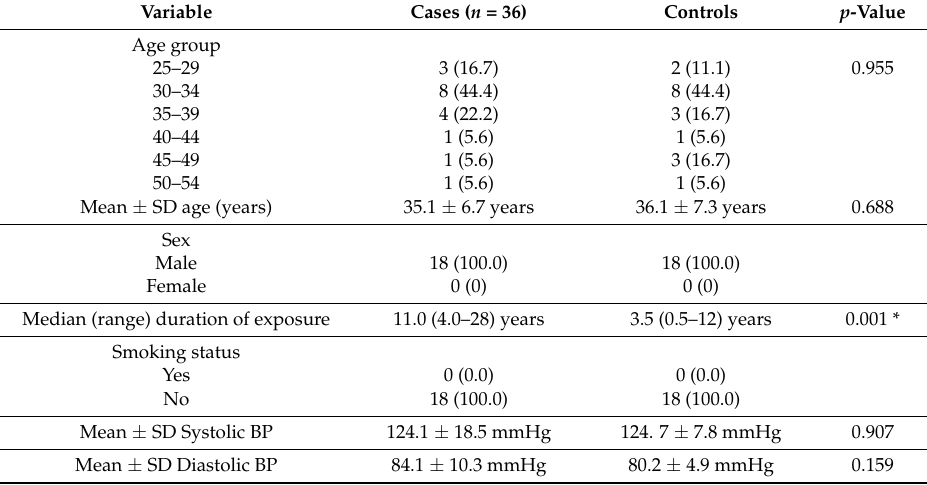
Table 1. Socio-demographic characteristics.